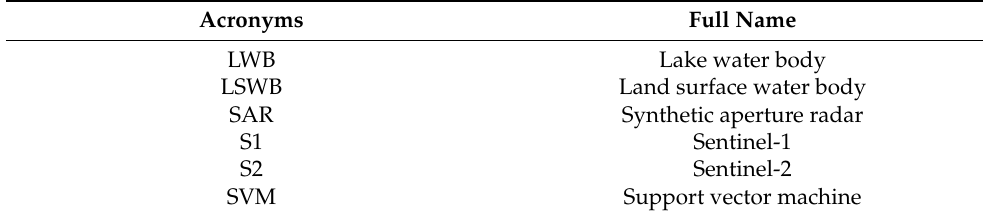
Table A1. List of